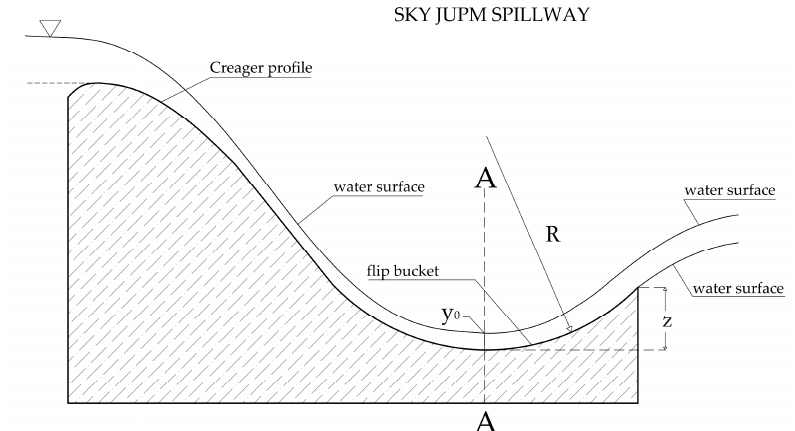
Figure 4. Section of a spillway with a flip bucket with a radius of curvature R and with a depth z , and flow depth y 0 at the lowest point of the flip bucket.